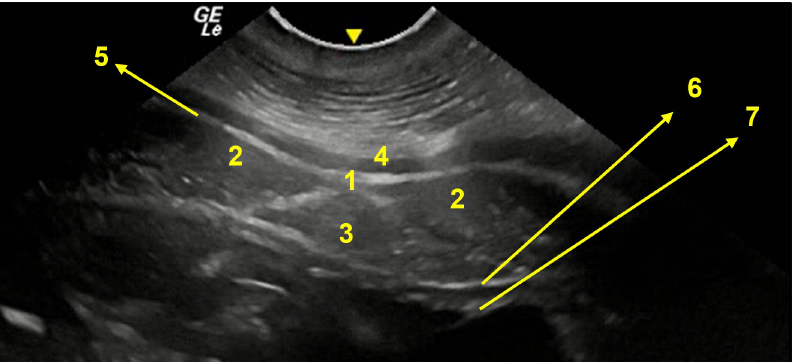
Figure 13. Transversal image of the umbilical region (B). 1. umbilical scar; 2. rectus abdominis muscle; 3. falciform fat; 4. cutaneous muscle; 5. profound fascia together with aponeurosis of external abdominal oblique muscle; 6. uterine horn wall.